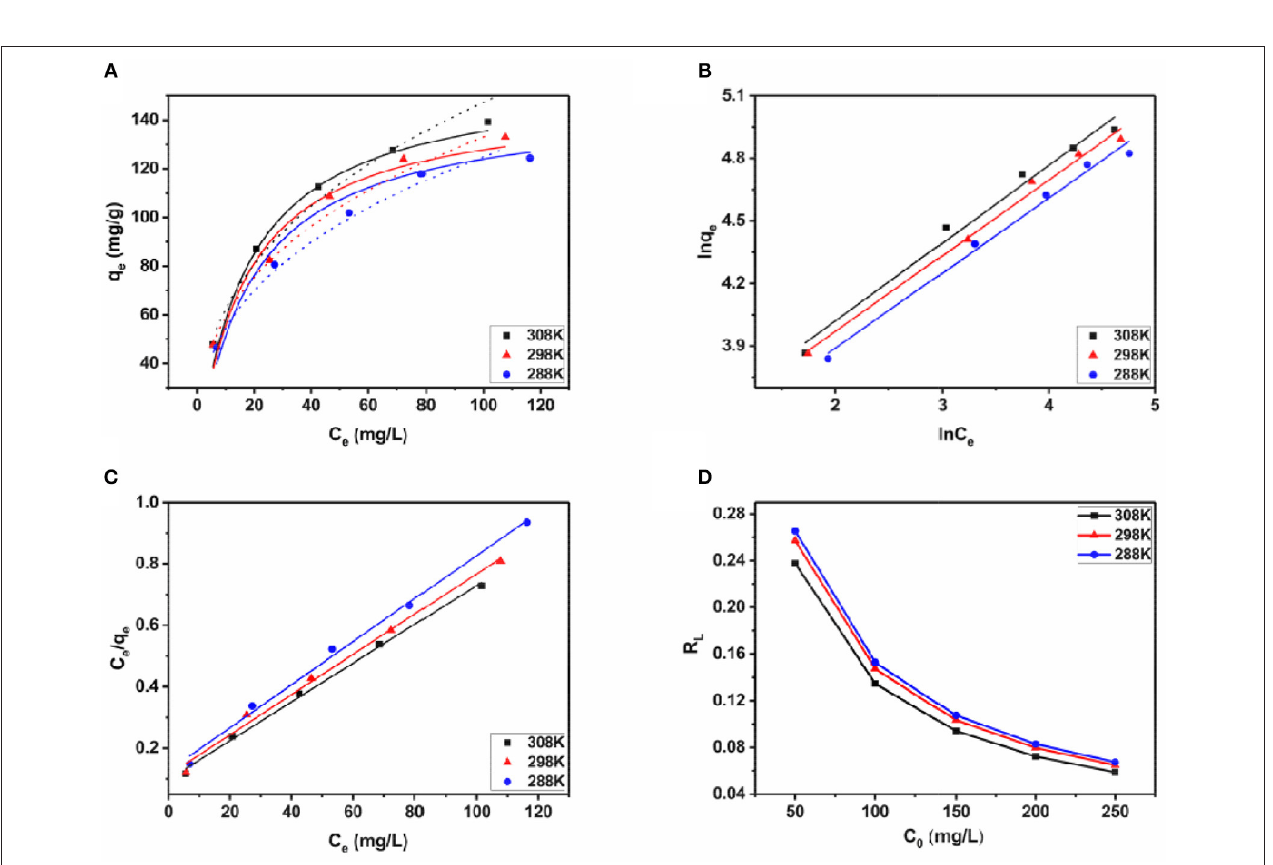
FIGURE 5 | (A) Data fittings with Langmuir and Freundlich adsorption isotherms of iodine adsorption over JLUE-COP-3 at different temperatures (288, 298, and 308K); solid lines: Langmuir model, dashed lines: Freundlich model. (B,C) are the Langmuir and Freundlich linear fittings for the iodine adsorption over JLUE-COP-3, respectively. (D) Separation factors for iodine adsorption over JLUE-COP-3.